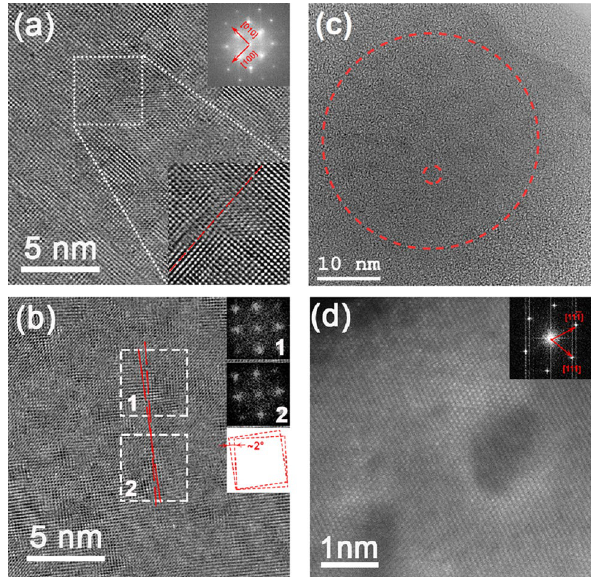
Figure 4. ( a – c ) HR TEM image of the NiO single crystal; sample normal is parallel to the [001] direction. ( a ) Structure contains linear features in two perpendicular directions marked by arrows. Reflection blurring in the corresponding FFT (inset top) can indicate the domain structure of the NiO crystal. The FFT filtered portion of the image is enlarged in the bottom right inset. The bending of a lattice fringe is highlighted by the dashed red line, which serves as an eye-guide. ( b ) Small scale HR TEM image reveals the presence of the crystalline domains. Two FFTs from neighbouring areas 1 and 2 demonstrate in-plane lattice rotation of approximately 2 that is shown schematically by two red misoriented squares. Two red dashed lines in ( b ) serve as an eye-guide to demonstrate the in-plane domain rotation. Disturbance of atomic resolution contrast confirms the out-of- plane lattice rotation. ( c ) The small dashed circle highlights an example of a small domain, similar in size to those visualised in ( a ), which agglomerate to form a larger feature (large circle). ( d ) HR STEM HAADF image. Electron beam is parallel to [110] NiO direction. Contrast indicates regions attributed to different nickel